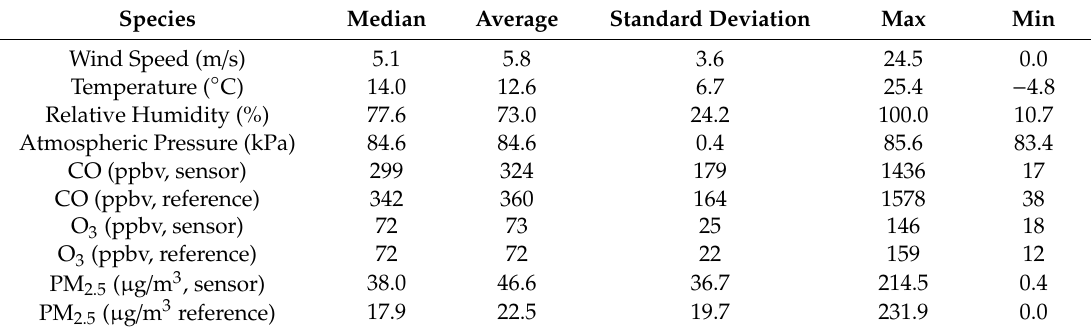
Figure 3. Time series of the measured metrological and air quality data at Mt. Tai from 20 April to 30 November 2018: ( a ) Wind speed (WS) and pressure, ( b ) temperature (T) and relative humidity (RH), ( c ) CO, ( d ) O 3 , and ( e ) PM 2.5 . Table 2. Statistics of the meteorological parameters and air pollutants measured by sensors and reference instruments at Mt. Tai during the inter-comparison